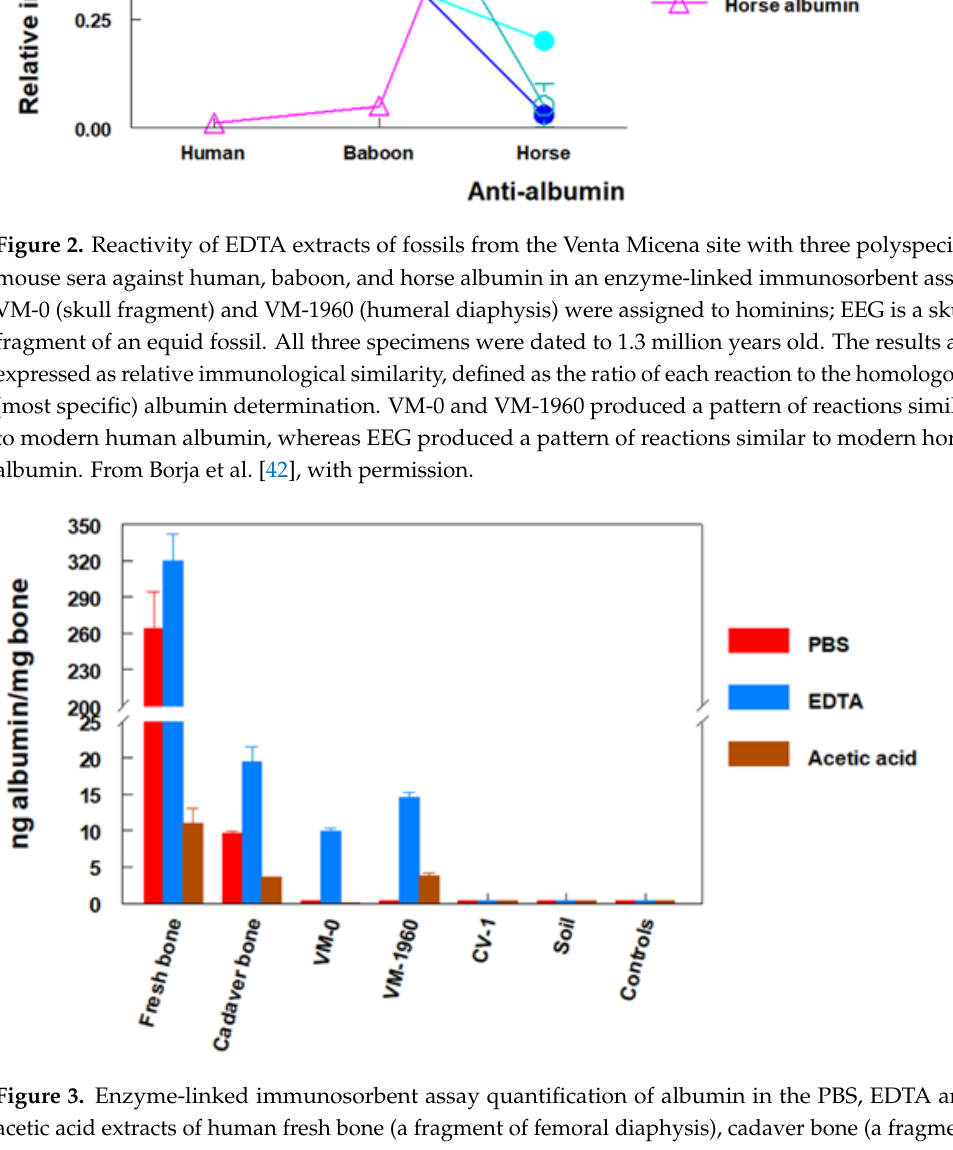
Figure 3. Enzyme-linked immunosorbent assay quantification of albumin in the PBS, EDTA and acetic acid extracts of human fresh bone (a fragment of femoral diaphysis), cadaver bone (a fragment of human occipital buried for approximately 10 years), fossils assigned to hominins (VM-0, VM-1960, CV-1), and soil collected around VM-0. Also shown are the buffers used for extractions, tested in the absence of bone. A mouse anti-human albumin polyclonal antiserum was used in all assays. From Lowenstein et al. [45], with permission. The fossil proteins were bound to the mineral phase of the bone, from which they were released by treating the samples with a decalcifying EDTA solution [42]. Proteins